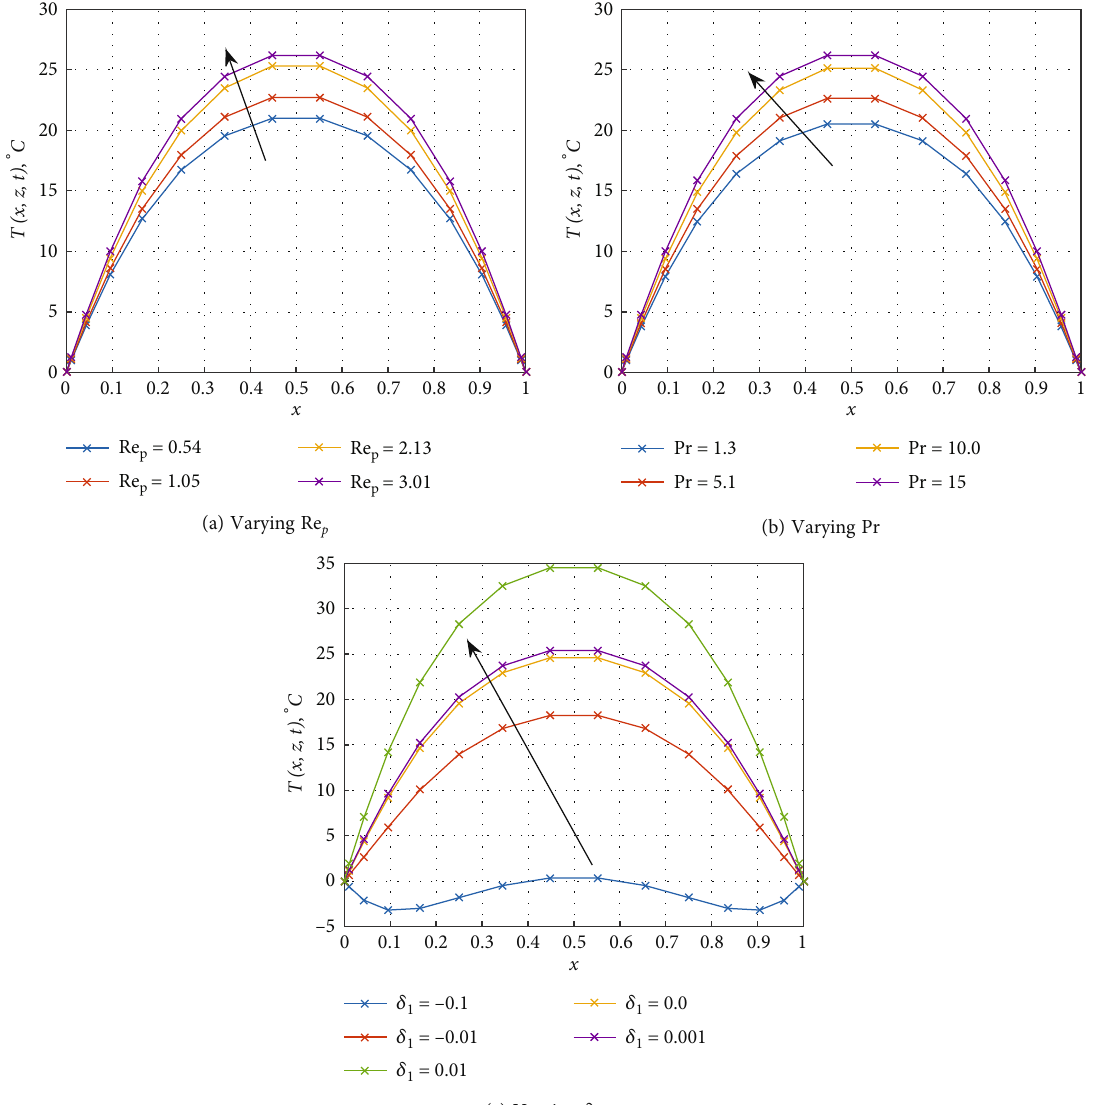
Figure 9: E ff ect of Re